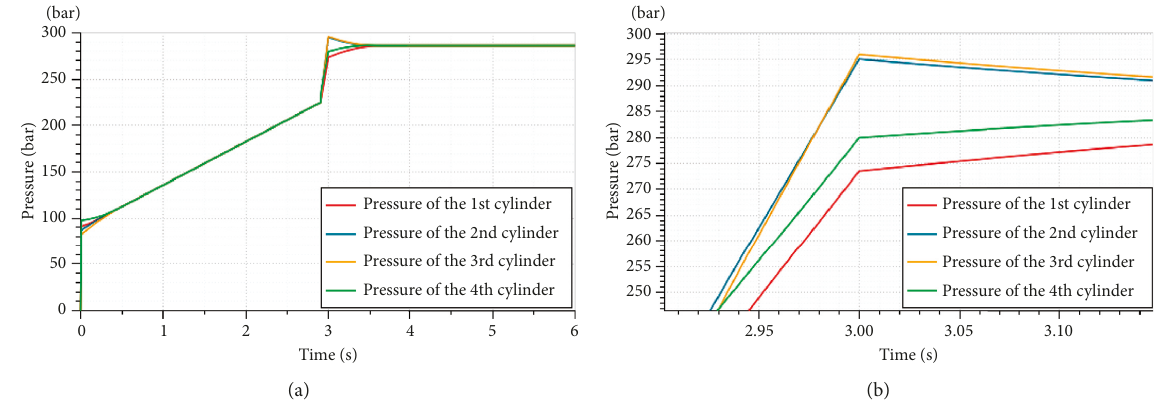
Figure 12: Pressure variation curves of each hydraulic cylinder without rod chamber in the connection device.